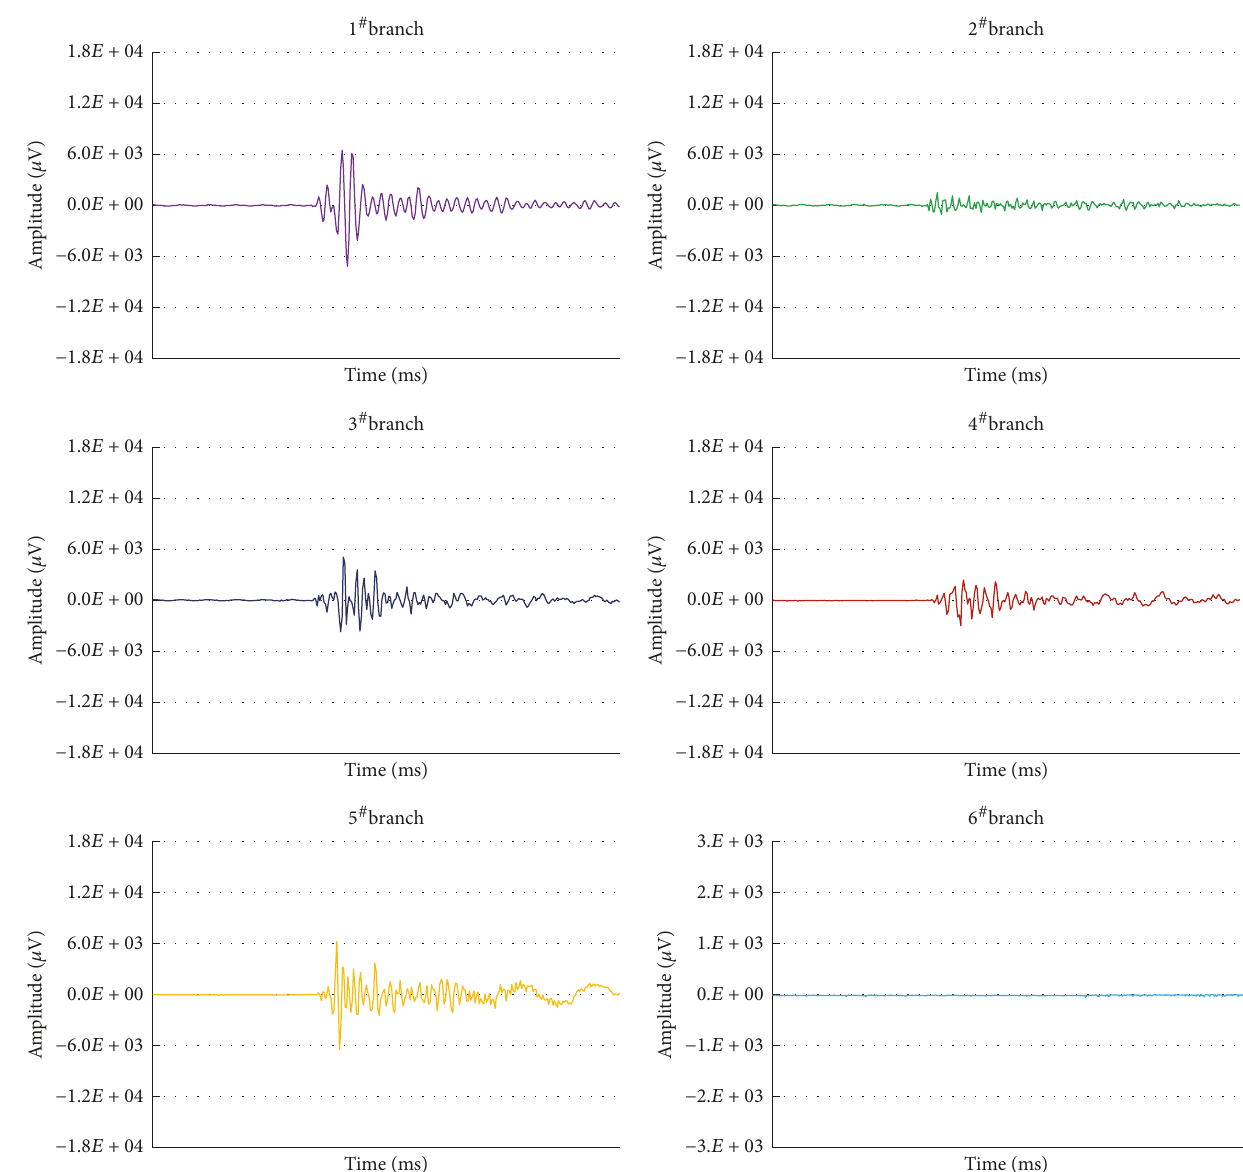
Figure 15: Level amplitude-time curves from different branch stations: different locations in the same section.